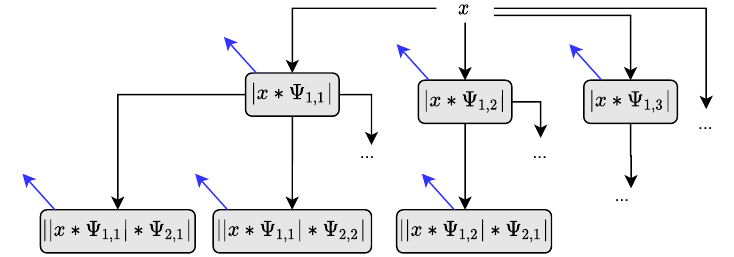
Figure 4. Scattering transform